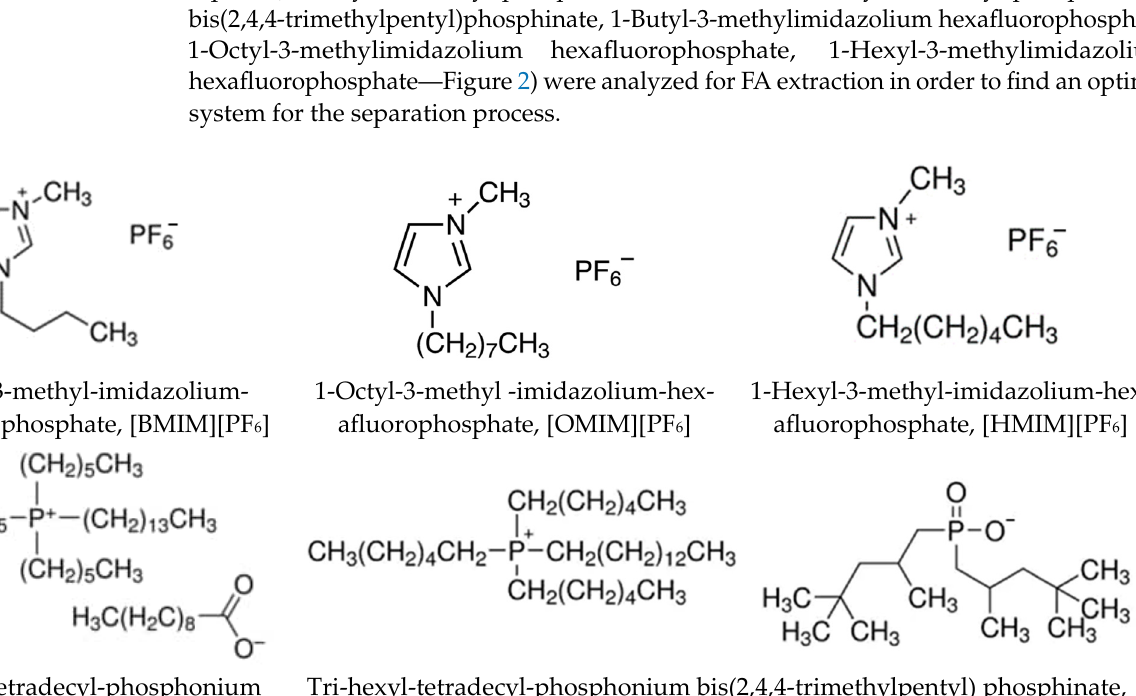
Figure 2. Ionic Liquids (IL) chemical structure.